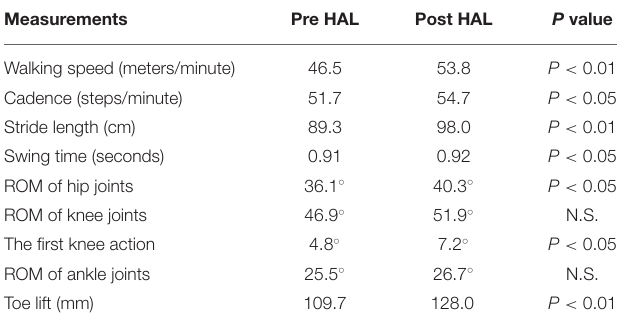
TABLE 4 | Comparison of gait kinematics between pre and post HAL intervention in chronic stage patients. Measurements